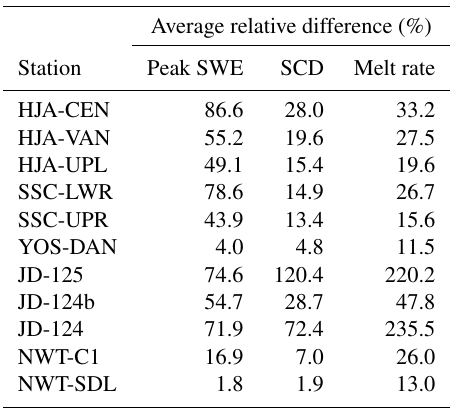
Table 5. Average relative differences in annual peak SWE, snow cover duration, and melt rate at the 11 stations. Relative differences were not computed for peak SWE date because the relative differ- ence value would change depending on if day of year or day of water year were used in the calculation.